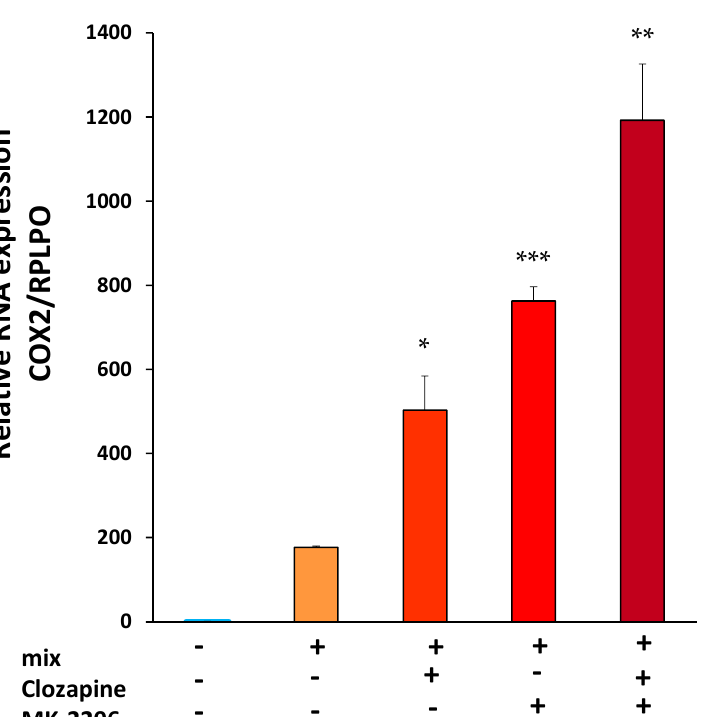
Figure 5. Effects of clozapine and MK2206 on COX2 gene expression. A172 cells were treated with clozapine (10 µ M) alone, MK2206 (1 µ M) alone, and a combination of both, 45 min before the addition of cytokine mix (mix). COX2 mRNA levels were determined by RT-PCR. (t = 3.98, df = 6, p < 0.01 for mix with clozapine vs. mix, t = 17.20, df = 6, p < 0.0001 for mix with MK vs. mix, t = 4.40, df = 6, p < 0.005 for mix with both clozapine and MK-2206 vs. mix with clozapine; n = 4 in each group). The figure represents one of two experiments with similar results. Data are presented as mean ± SEM. * p < 0.01 mix with clozapine vs. mix. ** p < 0.005 mix with both clozapine and MK-2206 vs. mix with clozapine. *** p < 0.0001 mix with MK-2206 vs.